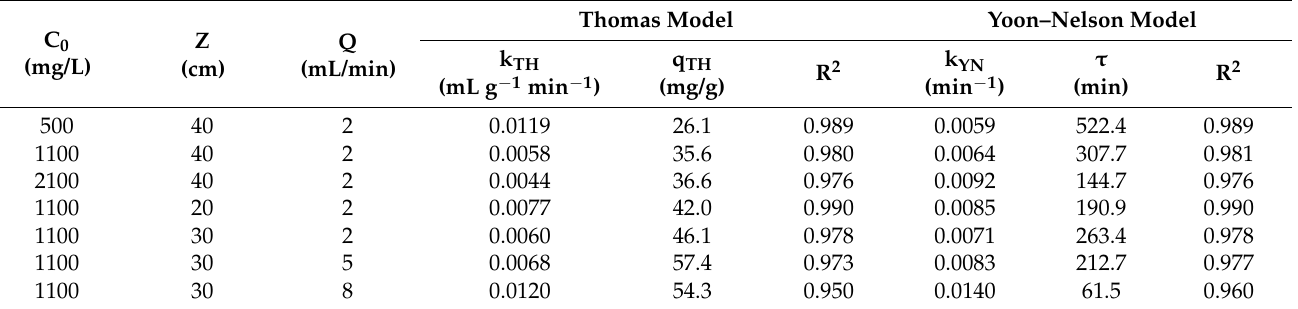
Figure 10. Breakthrough curves predicted by the Thomas Model under variable conditions: ( a ) variable bed heights, ( b ) variable initial sulfate concentration and ( c ) different inflow rates. Table 4. Predicted parameters of Yoon–Nelson and Thomas models, and model deviations for sulfate adsorption onto WS60.